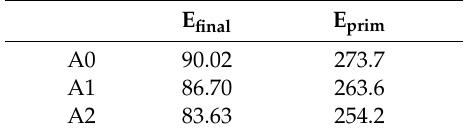
Table 4. Final and primary energy consumption in analyzed buildings.